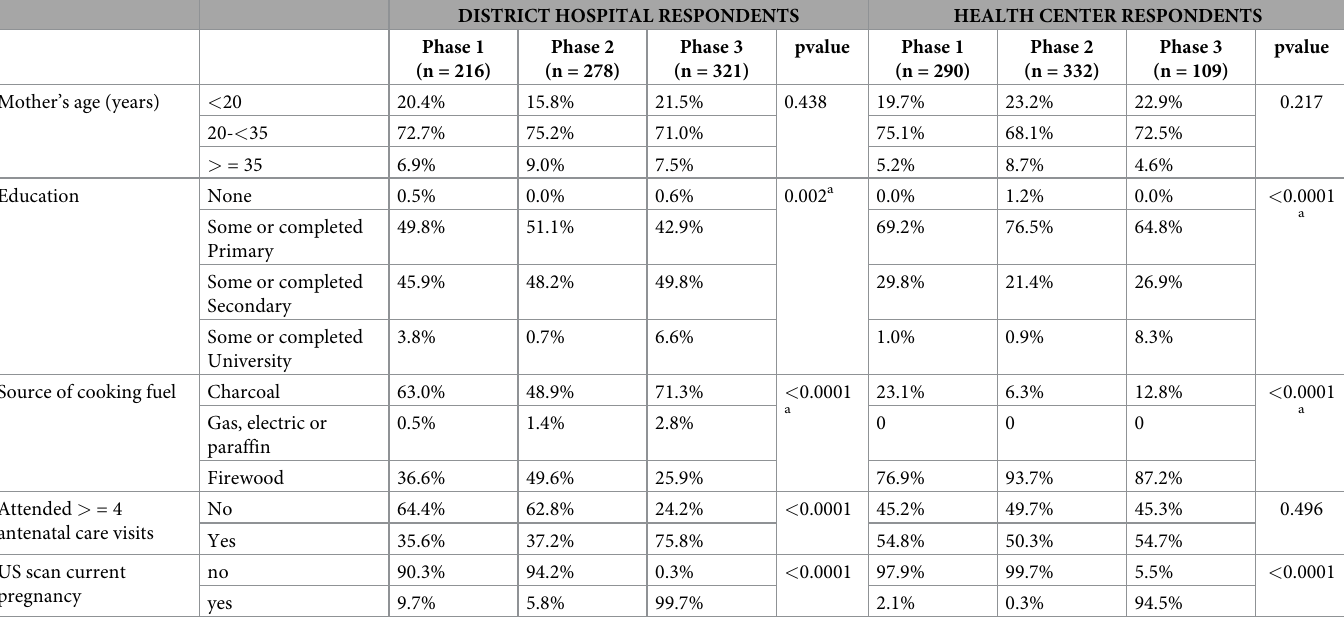
Table 2. Women’s sociodemographic and reproduction health characteristics across phases.